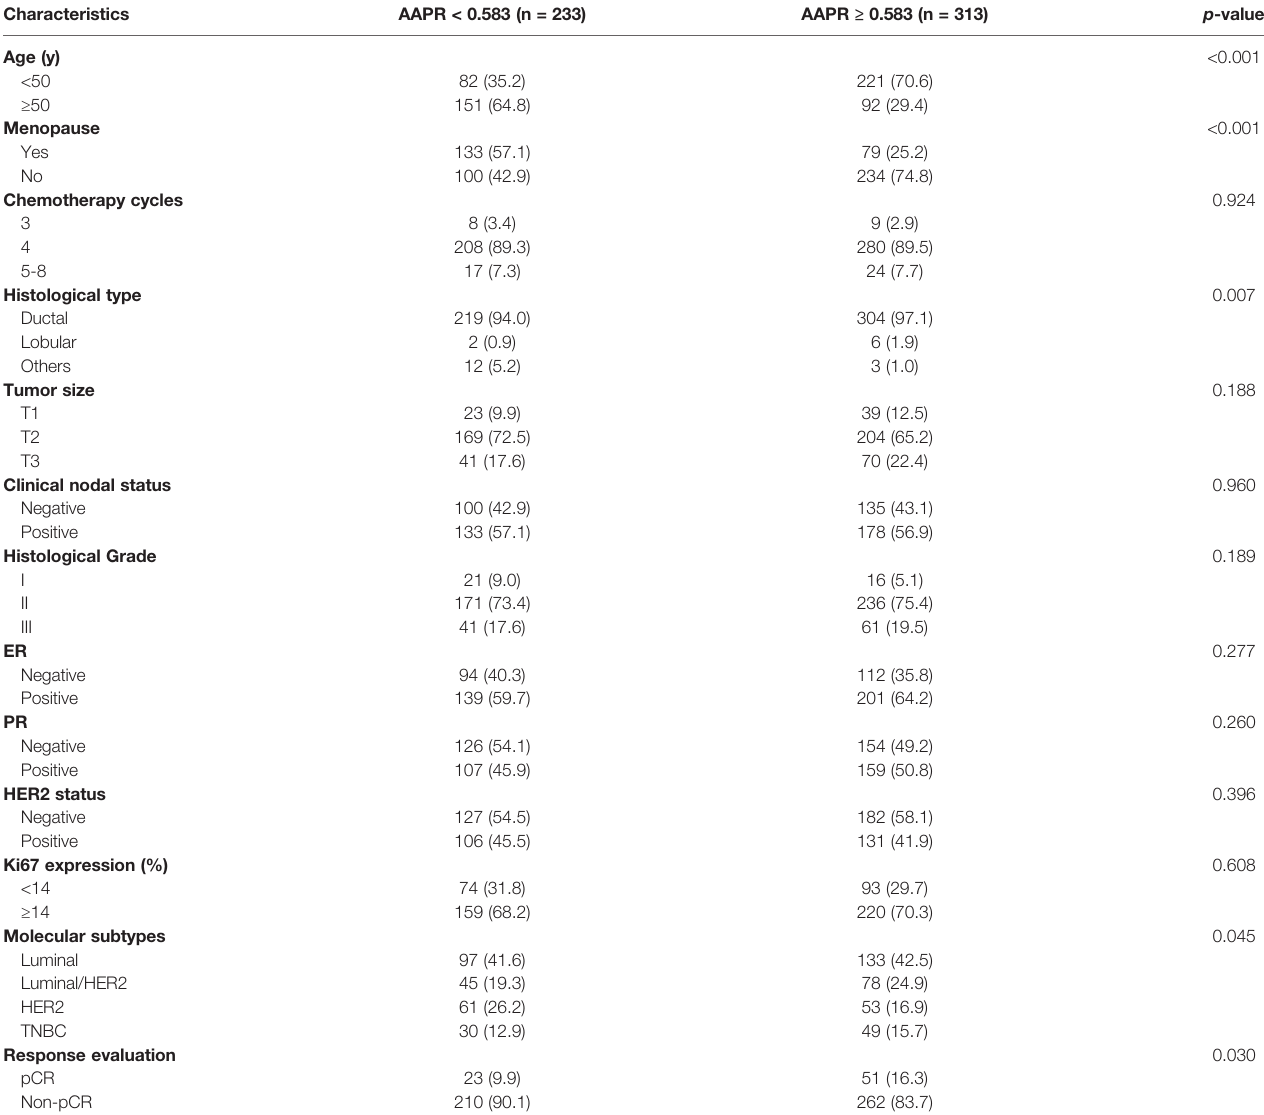
TABLE 2 | Correlations between AAPR and clinicopathological characteristics in the training cohort.